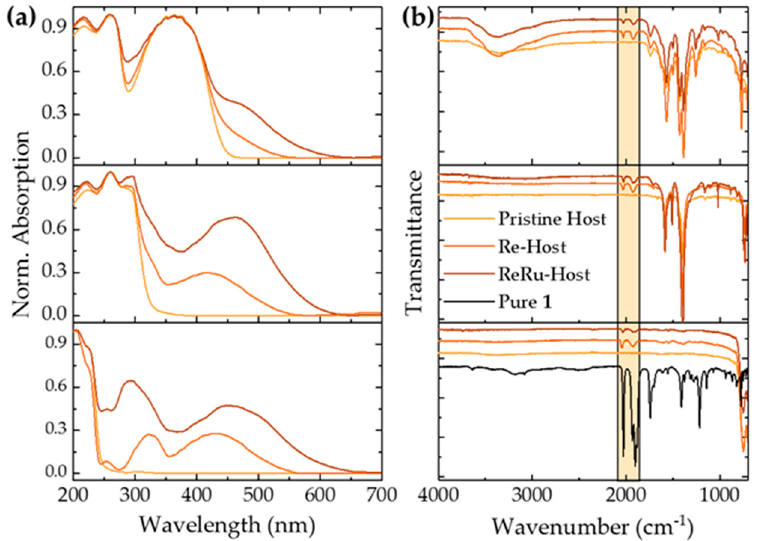
Figure 3. Solid-state UV-Vis and IR data for 66-NH 2 -based (top), 66-based (middle), and ZrO 2 -based (bottom) assemblies. ( a ) Normalized solid-state absorption spectra. ( b ) ATR-IR spectra, including pure catalyst 1 (black), and highlighting the Re(CO) 3 band region between 1850 and 2100 cm − 1 . ReRu-host samples are R = 0.5.